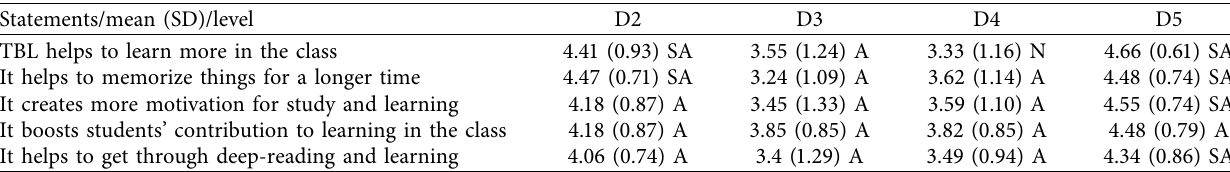
Table 1: Mean, standard deviation, and level of statements of the first parameter (knowledge acquisition), according to the Likert scoring method where SA is referred to strong agree, A is referred to agree, and N is referred to neutral.